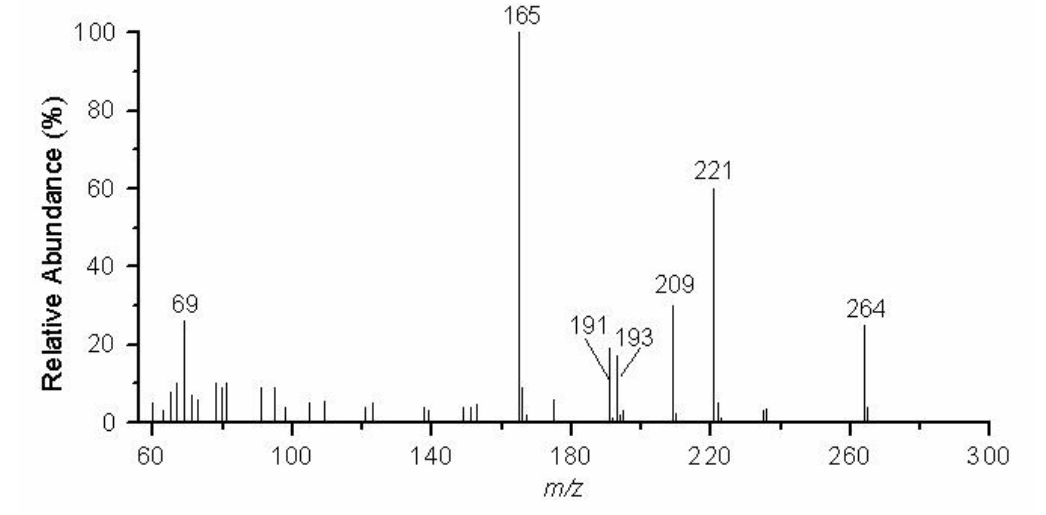
Figure 2 . EIMS (70 eV) of 5,7-dihydroxy-2,2-dimethyl-8-butyryl chroman (1